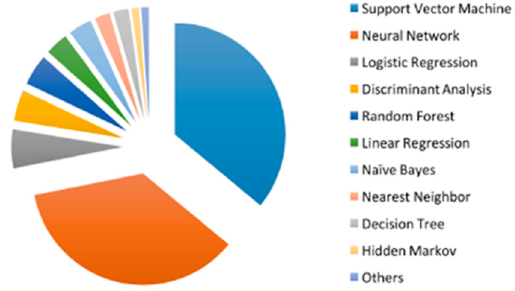
Figure 5. Machine learning algorithms used in healthcare sector [3].